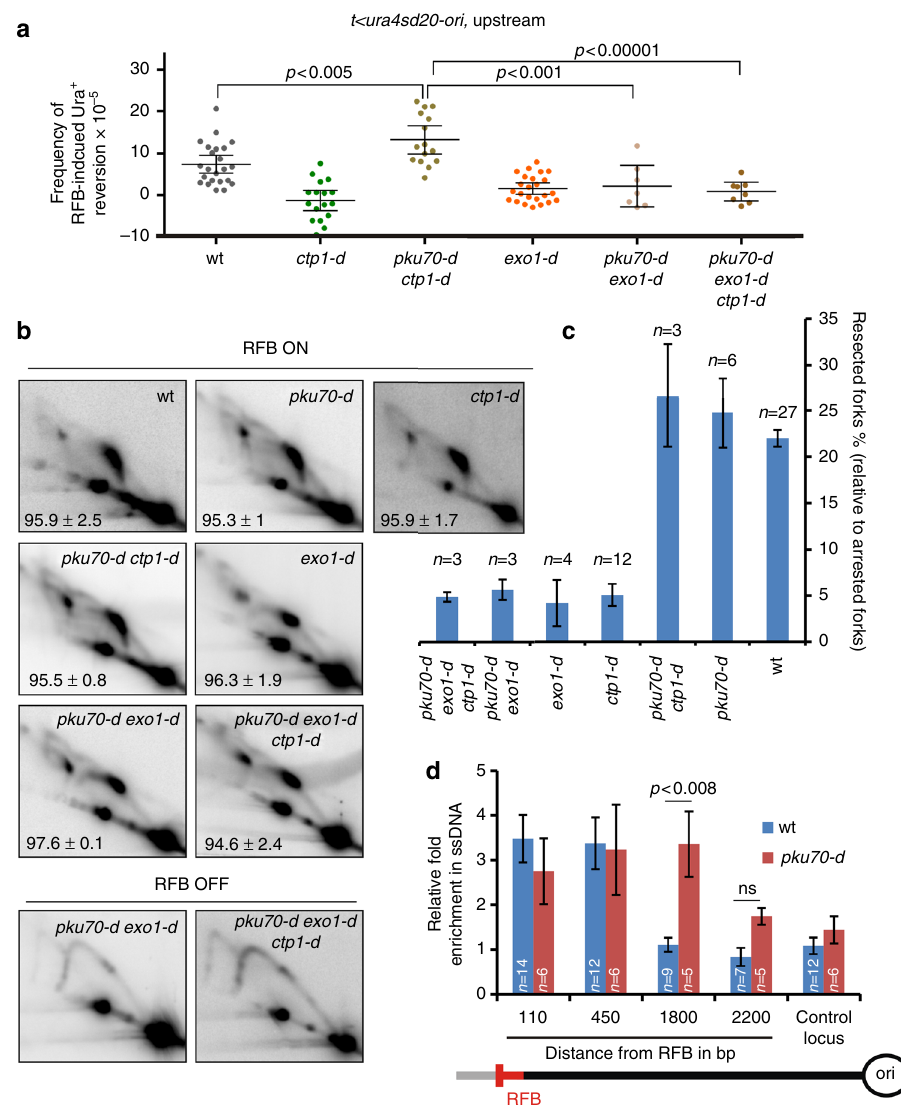
Fig. 5 Ku ensures that fork-resection occurs as a two-step process. a Frequency of upstream RFB-induced Ura + reversion, as described on Fig. 1c. b Representative RI analysis by 2DGE upon activation (RFB ON) or not (RFB OFF) of the RTS1 -RFB, as described on Fig. 1e. c Quanti fi cation of forks undergoing resection ( “ tail signal ” ), relative to the intensity of terminally arrested forks, as described on Fig. 1f. Values are means of n samples from independent biological replicates ± 95% CI. d Relative enrichment of ssDNA formed upstream from the RTS1 -RFB in indicated strains. The data shown are the fold enrichment in ssDNA in the ON condition (RFB active) relative to the OFF condition (RFB inactive). Values are means of n samples from independent biological replicates ± SEM. Statistics were calculated using Mann-Whitney U